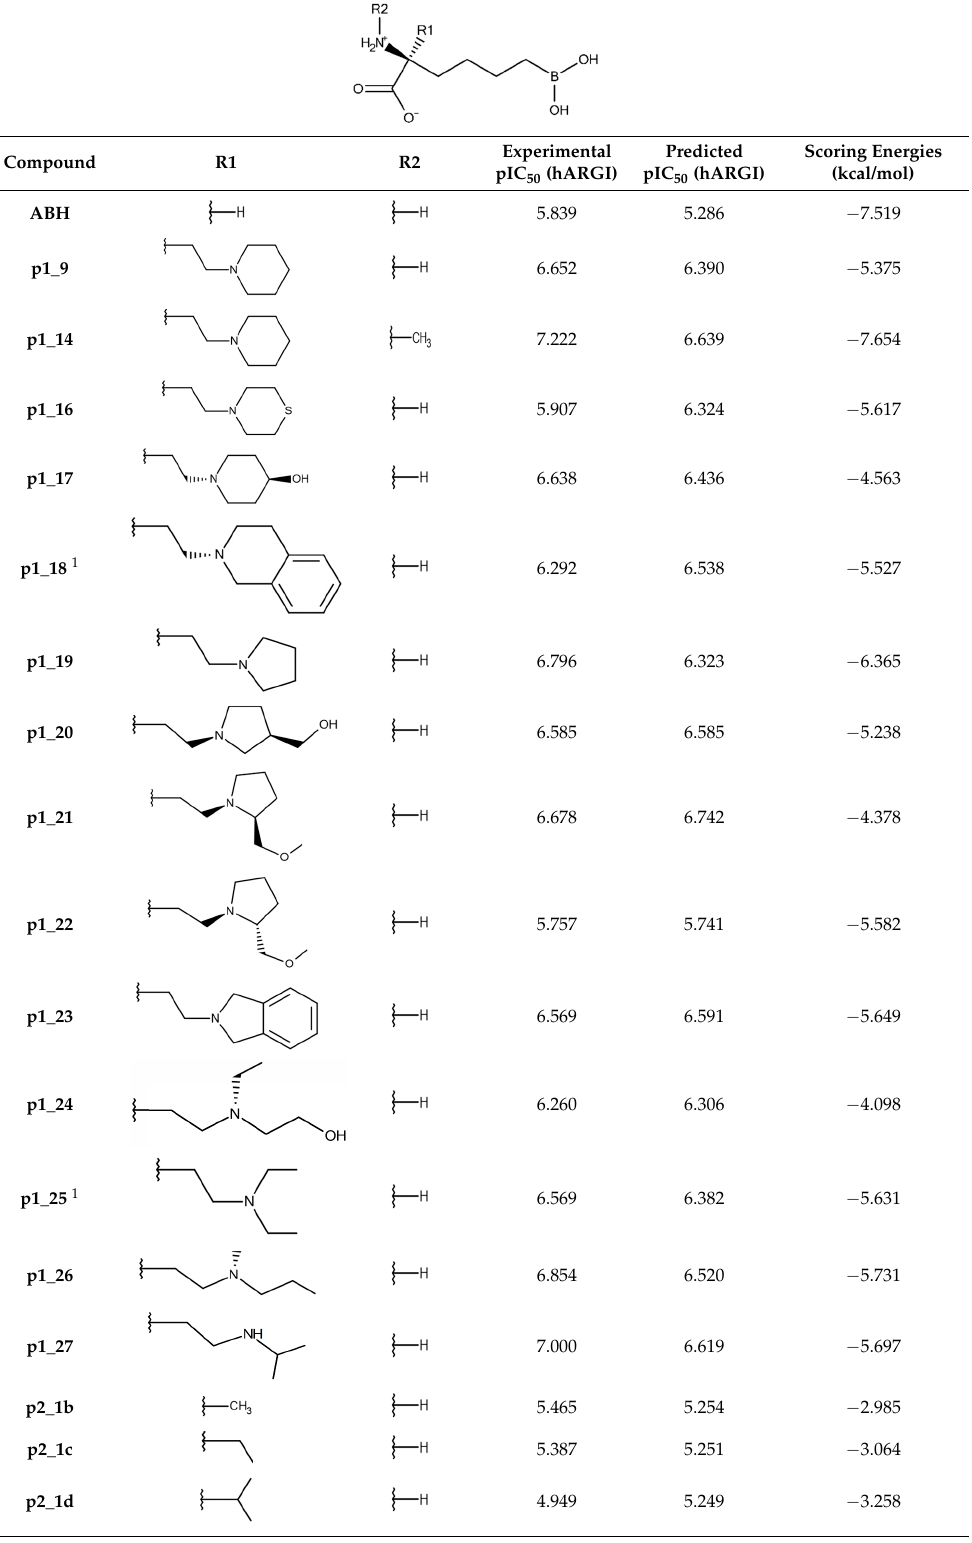
Table 1. Structures of ABH analogs as hARGI inhibitors. Experimental and predicted pIC 50 values using Model SE and docking Glide scoring energy values .